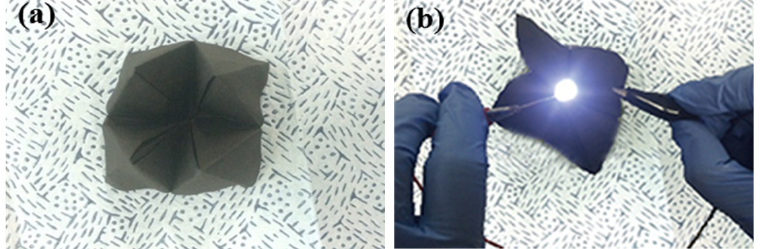
Figure 8. Photograph images of ( a ) flexible and folded SWCNT composite and ( b ) an LED lamp light shining through the SWCNT composite.